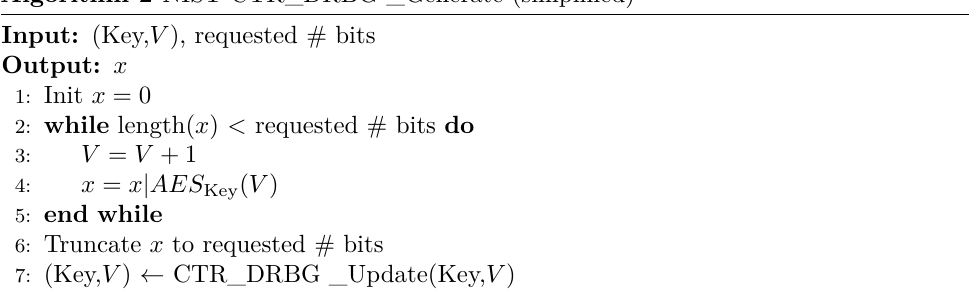
Algorithm 2 NIST CTR_DRBG _Generate